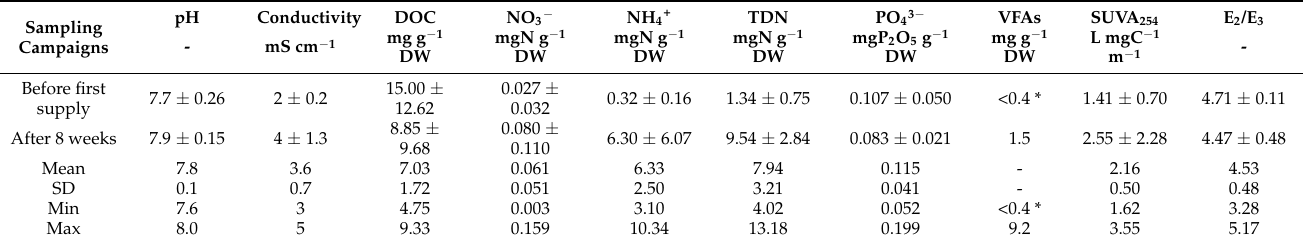
Table 2. Physico-chemical data ( ± CI, n = 3) of the water extracts (WEs) from the test biopile substrate. Min and Max: the values measured during the trial for each parameter ( n = 12, except for VFAs and before supply); and *: